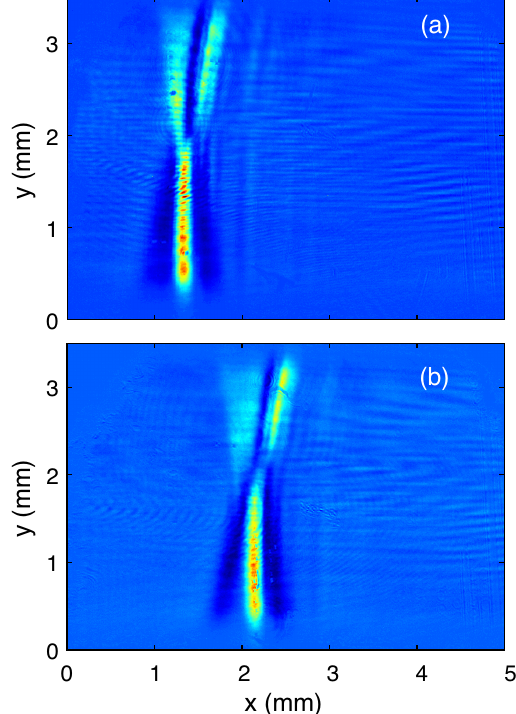
FIG. 4. The typical measurement results by the single-shot EO spatial decoding method near the focal plane of THz pulse. (a) THz pulse synchronization with the probe laser; (b) 2 ps delay between THz pules and probe